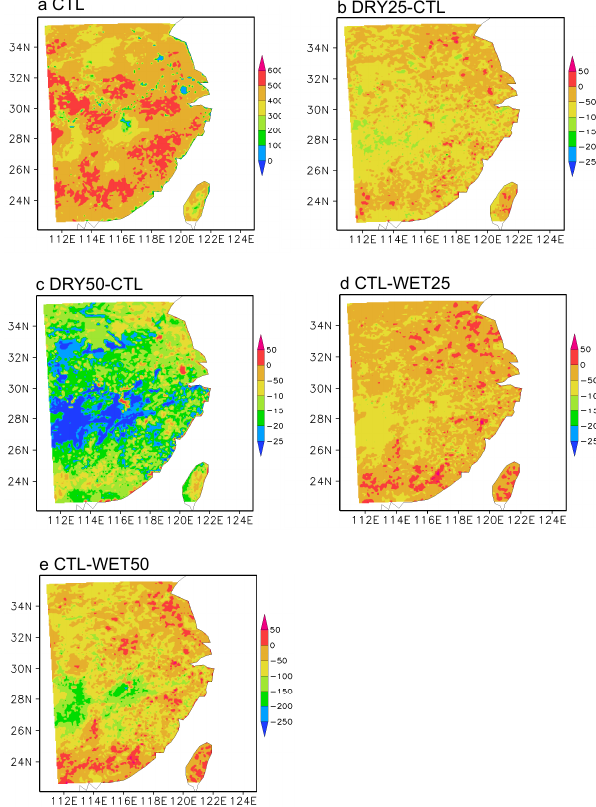
Figure 7. The spatial distributions of the 10-day mean 06:00UTC sensible heat fluxes in the simulations (unit: Wm − 2 ) .